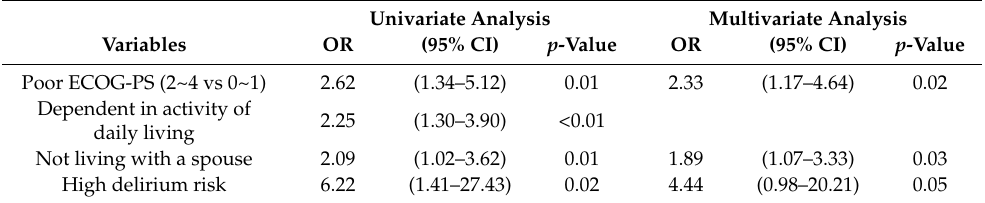
Table 3. Multivariate analysis of the factors associated with upfront dose reduction.